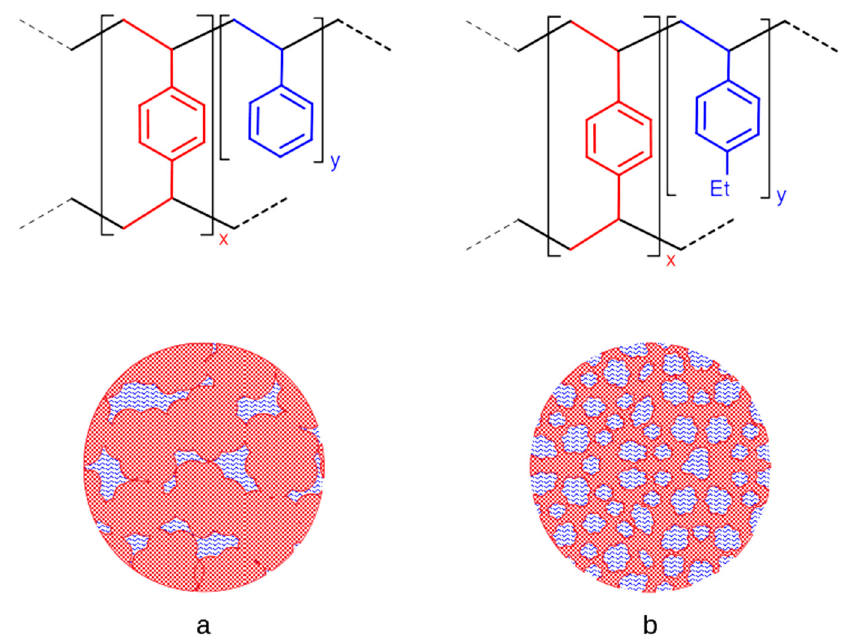
Figure 2. Sketch of the chemical structure (top) and of the pore morphology (bottom) of a typical macroreticular pSDVB resin ( a ; x=15, y=85) and of µ-pDVB ( b ; x=85, y=15). Ethylstyrene from technical grade divinylbenzene usually employed in polymerization is the source of the ethylbenzene moieties, which can be also present in low amount in pSDVB (omitted for simplicity).